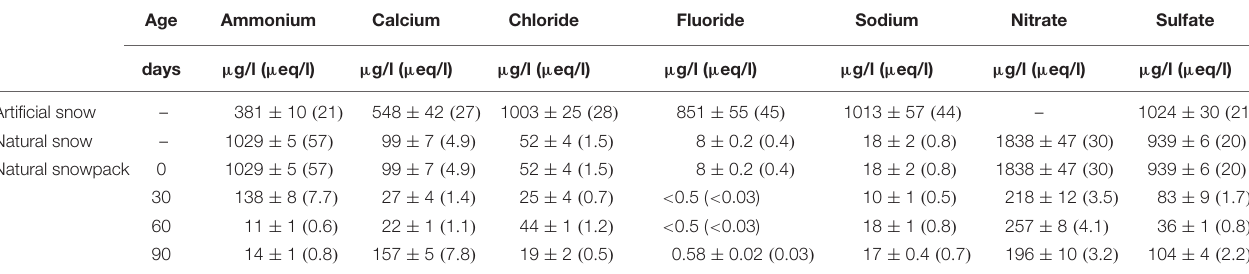
TABLE 1 | Comparison of the bulk concentrations C Bulk for the different ions in µ g/l together with the standard deviation based on the analyses of 3